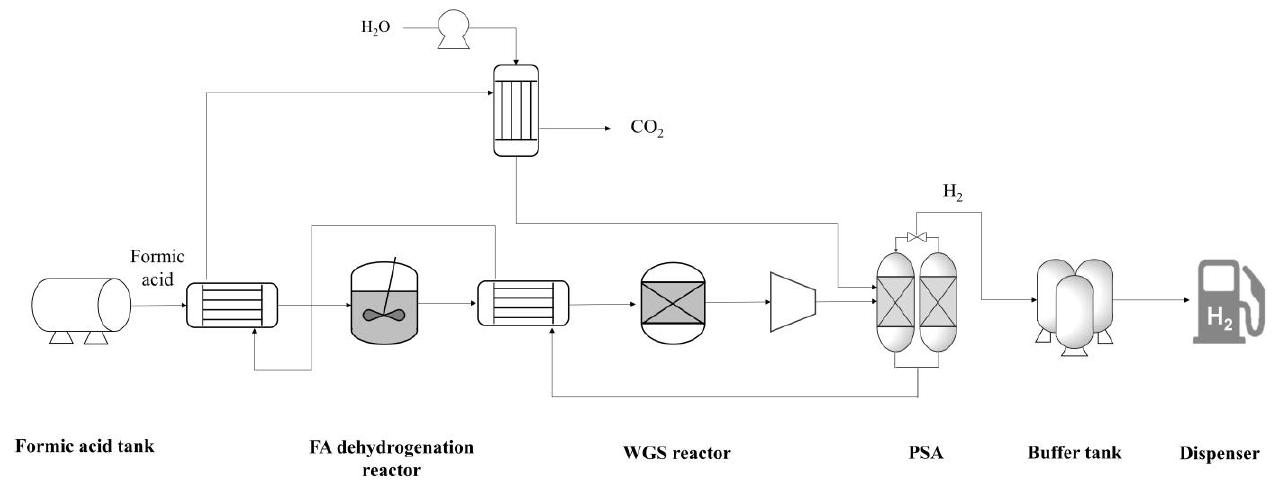
Figure 1. PFD of the FAHRS system. Heat exchangers are used to maximize the energy